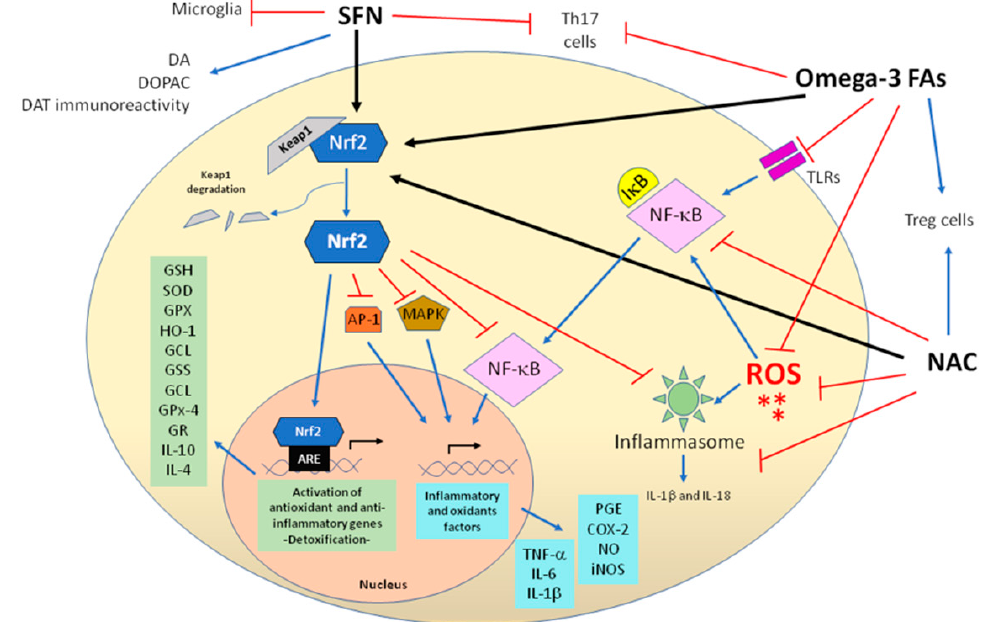
Figure 2. Overview of the mechanisms of SFN, NAC and Omega-3 FAs used as modulators against inflammation and oxidative stress. DA, dopamine; DOPAC, 3,4-dihydroxyphenylacetic acid; DAT, dopamine transporter; PGE, prostaglandins; ROS, reactive oxygen species; NO, nitric oxide; GCL, glutamate cystine ligase; GPx, glutathione peroxidase; GSH, glutathione; SOD, superoxide dismutase; GR, glutatione reductase; GSS, glutathione synthetase; glutathione peroxidase-4, GPx-4. The molecular mechanism by which SFN exerts its anti-inflammatory function is by inducing Nrf2 pathway activation, which contributes to the anti-inflammatory process by regulating HO-1 gene expression [59–61]. Nrf2 leads to the inhibition of nuclear factor kappa B (NF- κ B), activator protein-1 (AP-1) and mitogen-activated protein kinase (MAPK) classical inflammatory pathways, resulting in decreased expression of the inflammatory mediators (iNOS, COX-2, NO and prostaglandins) and pro-inflammatory cytokines (TNF- α , IL-6 and IL-1 β ). In addition, Nrf2 / HO-1 activation increases anti-inflammatory cytokines (IL-10 and IL-4) [62–65]. Moreover, SFN has a prophylactic and a therapeutic e ff ect by inhibiting both the inflammatory response and microglial activation